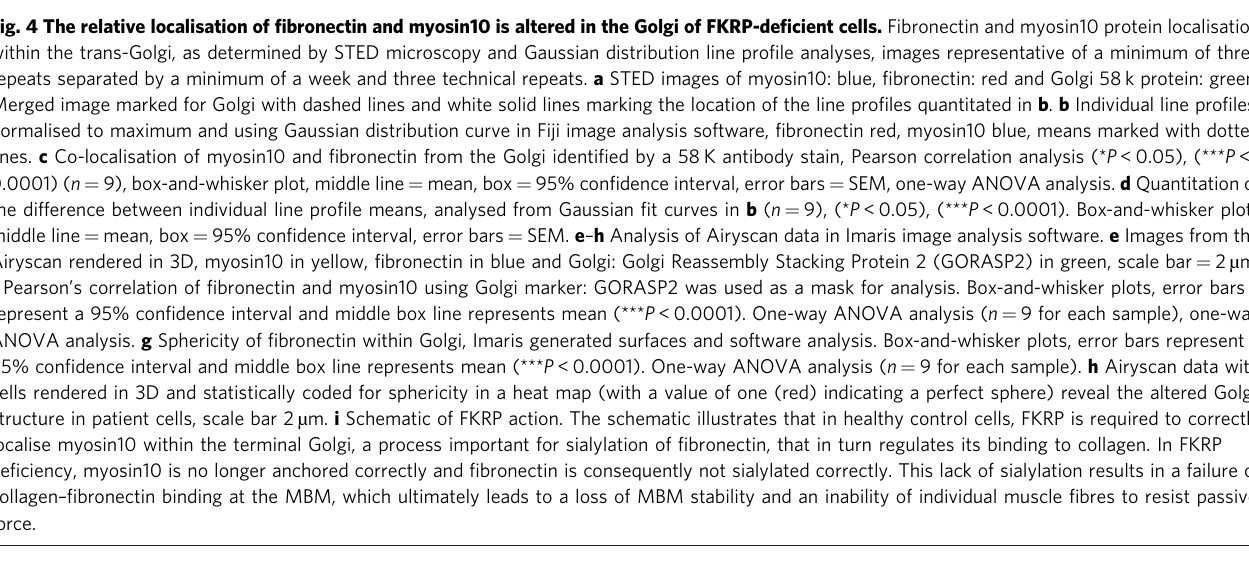
Fig. 4 The relative localisation of fi bronectin and myosin10 is altered in the Golgi of FKRP-de fi cient cells. Fibronectin and myosin10 protein localisation within the trans-Golgi, as determined by STED microscopy and Gaussian distribution line pro fi le analyses, images representative of a minimum of three repeats separated by a minimum of a week and three technical repeats. a STED images of myosin10: blue, fi bronectin: red and Golgi 58 k protein: green. Merged image marked for Golgi with dashed lines and white solid lines marking the location of the line pro fi les quantitated in b . b Individual line pro fi les, normalised to maximum and using Gaussian distribution curve in Fiji image analysis software, fi bronectin red, myosin10 blue, means marked with dotted lines. c Co-localisation of myosin10 and fi bronectin from the Golgi identi fi ed by a 58 K antibody stain, Pearson correlation analysis (* P < 0.05), (*** P < 0.0001) ( n = 9), box-and-whisker plot, middle line = mean, box = 95% con fi dence interval, error bars = SEM, one-way ANOVA analysis. d Quantitation of the difference between individual line pro fi le means, analysed from Gaussian fi t curves in b ( n = 9), (* P < 0.05), (*** P < 0.0001). Box-and-whisker plot, middle line = mean, box = 95% con fi dence interval, error bars = SEM. e – h Analysis of Airyscan data in Imaris image analysis software. e Images from the Airyscan rendered in 3D, myosin10 in yellow, fi bronectin in blue and Golgi: Golgi Reassembly Stacking Protein 2 (GORASP2) in green, scale bar = 2 µ m. f Pearson ’ s correlation of fi bronectin and myosin10 using Golgi marker: GORASP2 was used as a mask for analysis. Box-and-whisker plots, error bars represent a 95% con fi dence interval and middle box line represents mean (*** P < 0.0001). One-way ANOVA analysis ( n = 9 for each sample). h Airyscan data